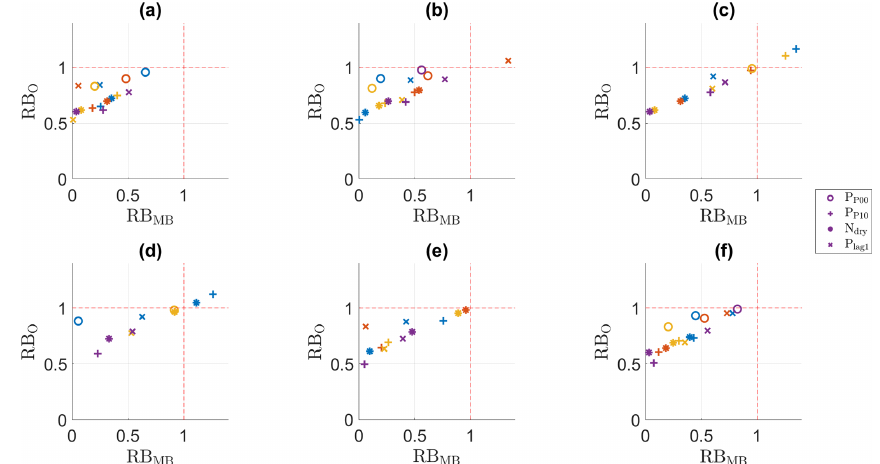
Figure 8. RB MB versus RB 0 for the correlation indices in the validation period. (a) QDM, (b) mQDM, (c) MBCn, (d) MRQNBC, (e) dOTC, (f) R 2 D 2 . Winter: blue, spring: ochre, summer: yellow, autumn: purple.